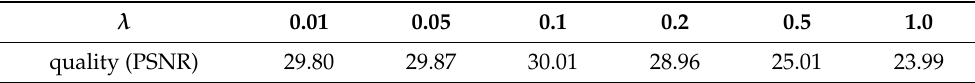
Table 4. Effects of regularization factor of the proposed objective